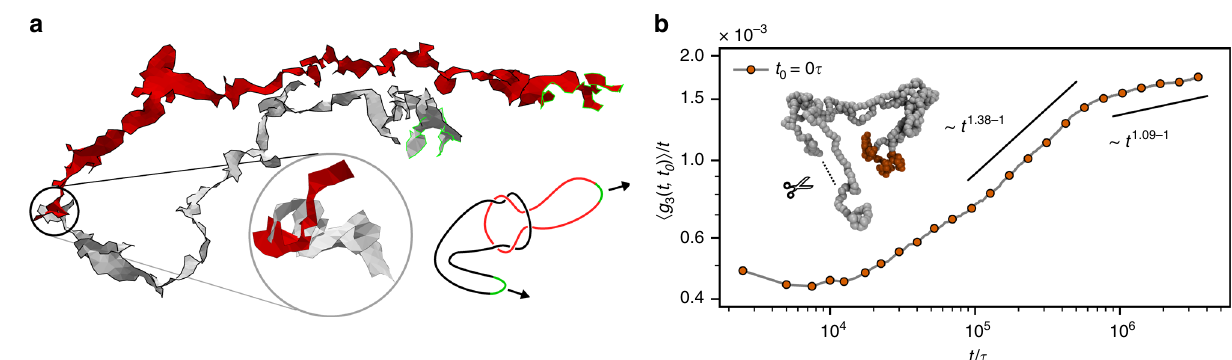
Fig. 7 Tight threading and relaxation of cut rings. a Two partly active rings with their minimal surfaces revealing a tight threading (detail in the inset). Active segments are marked green. Their sketched conformation shows how the directionality tightens the threading and introduces long relaxation. These as well as other threadings pose no long-time constraint if the rings were cut. b Mean squared displacement of the cut rings divided by time ( t is measured from the cutting event). The initial decrease at short times is the residual effect of the glassy state, until the former topological constraints get released and the centers of mass of the rings switch to superdiffusion at intermediate times. Later on, the chains cross over to the usual diffusion. Inset: snapshot of a cut ring at